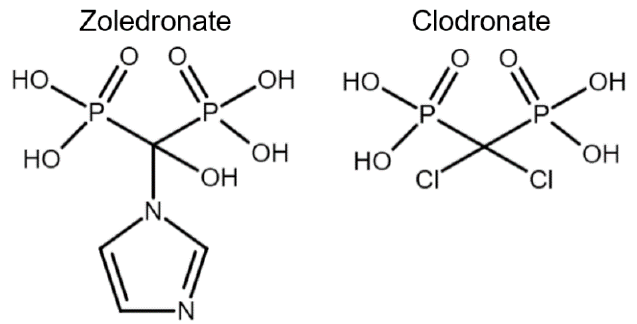
Figure 2. Chemical structure comparison between a third-generation nitrogen-containing BP (zoledronate) and a first-generation non-nitrogen-containing BP (clodronate). The pharmacokinetics (PK) of BPs depends on the route of administration. BPs are poorly absorbed orally, attributed likely to their low lipophilicity [28]. Oral bioavailability in humans has been estimated between 0.3% for pamidronate [29], 0.7% for alendronate [30], and 1 – 2% for clodronate [31]. Parenteral routes provide better and nearly complete absorption of BPs [28]. Initial tissue distribution depends on the protein-biding properties and will vary depending on blood pH, serum calcium, drug dosage, and species [28]. Though there is evidence of non-calcified tissue retention of BPs at high dosages [32,33], the probability of this occurring at therapeutic dosages is minimal [28]. BP distribution is not homogeneous in the skeleton and may be affected by sex and age. BPs tend to bind to the trabecular bone because of larger amounts of bone turnover and blood supply in com- parison to cortical bone [34 – 36]. Young animals may have an increased absorption rate compared to adults, and females may absorb less BP than males [33]. Once in the bone, BPs are absorbed by osteoclasts via endocytosis [23,25]. As bone resorption continues, BPs reactivate, resulting in prolonged osteoclastic inhibition over time [20]. For this reason, BPs’ half -life is difficult to define and may be up to 10 years depending on species, age, and the specific BP [4,28]. Clodronate and etidronate (sBPs) can undergo intracellular metabolization [37]; on the other hand, there is no evidence of metabolization of nBPs [36]. BPs not taken up by the bone are largely excreted unaltered by the kidneys [28,36]. In human and rat studies, BPs half-life ranges between 1 to 2 h, a quick bloodstream elimination that depends on kidney excretion (renal clearance) and bone uptake (nonrenal clearance); this ratio varies among BPs. In humans, the clodronate renal/nonrenal clearance ratio is between 1.8 to 3 in comparison to pamidronate, which is 0.18 [28]. Additionally, the same class of BPs may differ in some PK parameters. For example, clodronate and tiludronate are sBPs with sim- ilar potency [22], yet the half-life of clodronate is reported to be between 2 and 3 h [38,39], and tiludronate’s half -life is much longer (51 h) [40]. Therefore, it is not accurate to extrap- olate drug properties, even if BPs belong to the same class [41]. Because of this, studies must evaluate each BP and its individual effects on bone modeling and remodeling. 5. Therapeutic Effects of Bisphosphonates Human conditions treated with BPs include postmenopausal osteoporosis, Paget ’ s disease, osteogenesis imperfecta, and bone cancer/metastasis [42,43]. Bisphosphates are used to decrease bone resorption and increase bone mineral density (BMD) by decreasing bone catabolism. In addition to their main antiresorptive properties, BPs are believed to have anti-in- flammatory and analgesic effects [4,44 – 48], which make them an attractive potential treat- ment for multiple diseases, including osteoarthritis (OA). Meta-analyses and systematic reviews have concluded that BP studies have controversial results, and BP effects may be more related to pain relief than disease modification [48 – 50]. These pain-relieving effects